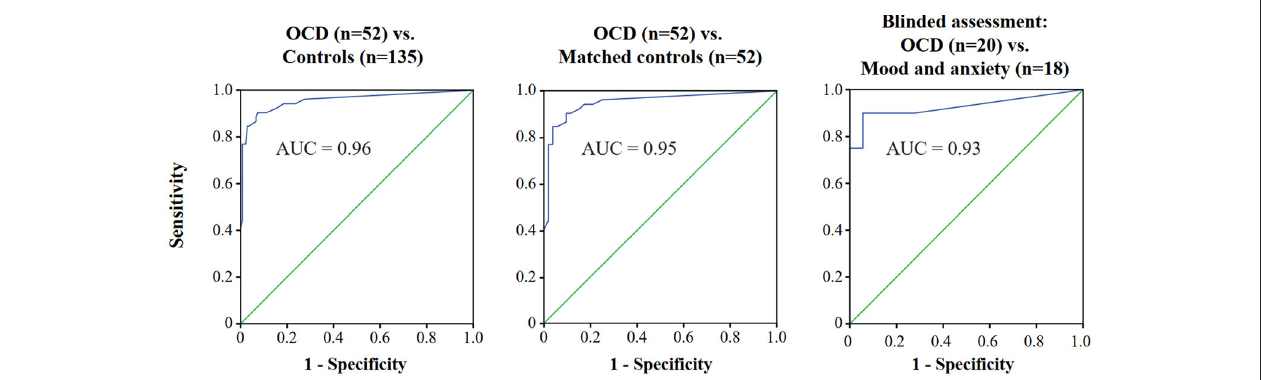
FIGURE 2 | ROC curves for use of the Y-BOCS-II to identify OCD. Plot of the true positive rate (1—specificity) against the false positive rate (sensitivity) for the different possible cut-offs of the Y-BOCS-II using the SCID-OCD as the diagnostic instrument. In the left panel, all participants were considered. In the middle panel, OCD and age-, gender-, and education-matched controls (balanced mixture of healthy subjects and patients with mood and anxiety disorders) are considered. In the right panel, patients who completed a blinded assessment are considered. ROC, Receiver operating characteristic; Y-BOCS-II, Yale-Brown Obsessive-Compulsive Scale-II; OCD, Obsessive-compulsive disorder; AUC, Area under the